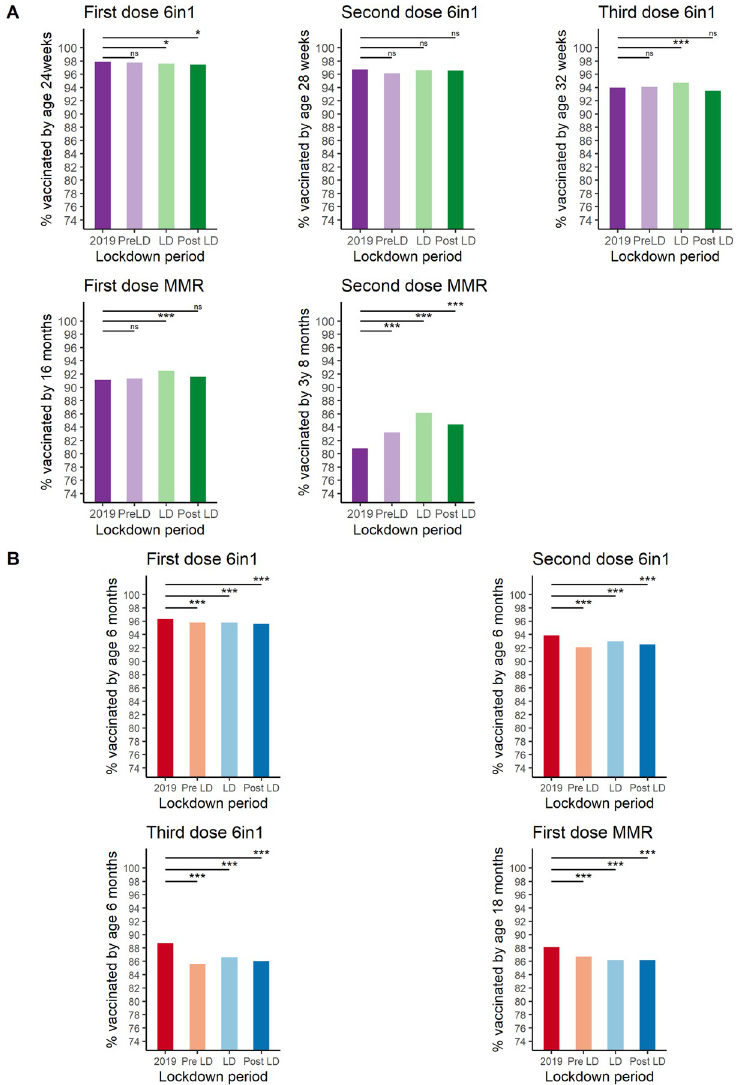
Fig 4. Percentage of children up to date at 6/18 months in Scotland and England. Overall mean percentage of children immunised by approximately 6 months of age (all doses of 6 in1, see y-axis for specific ages) or 16–18 months (first MMR) for Scotland and England. Each bar contains children who became eligible for the immunisation of interest during the time period indicated. (A) Scotland, (B) England ��� p -value < 0.001, � p -value < 0.05, ns, not significant. p -values calculated using binary logistic regression. LD, lockdown; MMR, measles, mumps, and rubella; PostLD, postlockdown; PreLD, prelockdown.